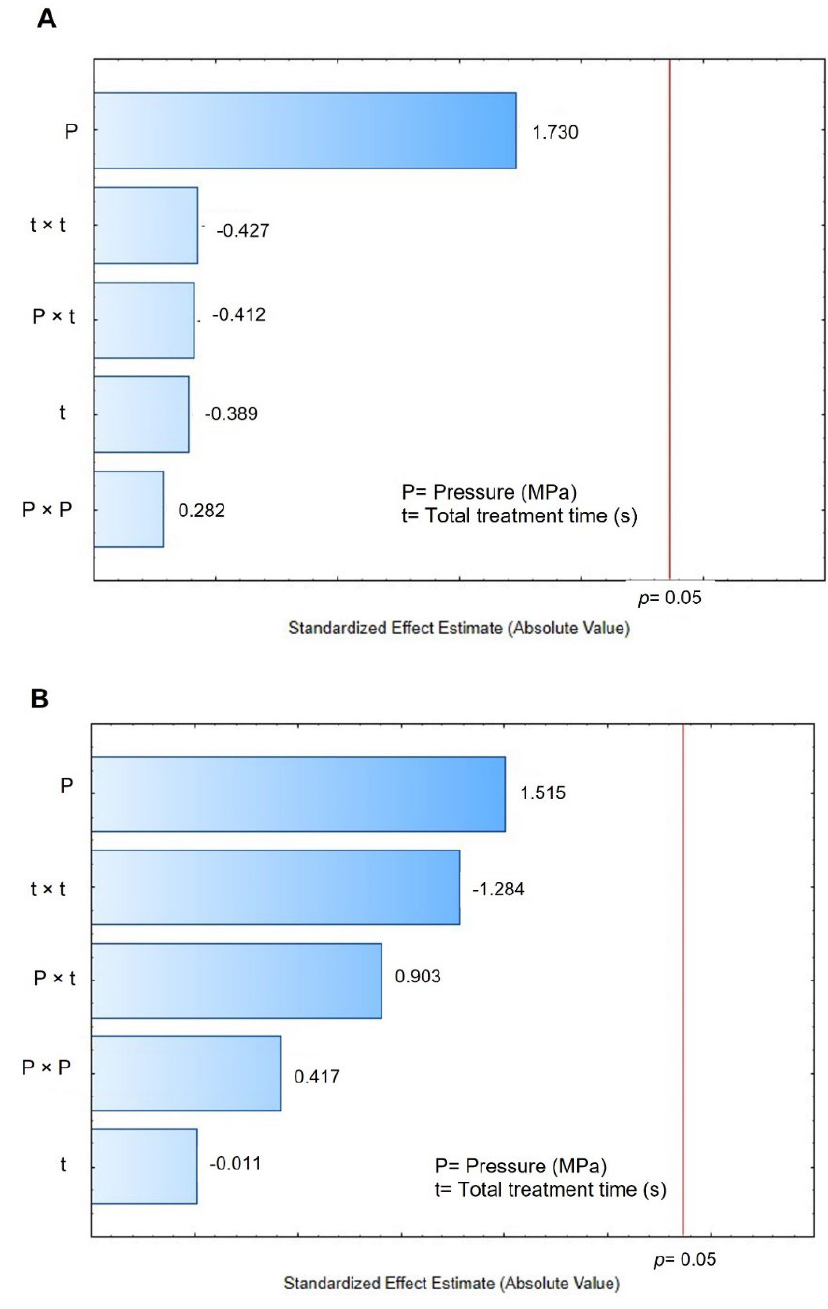
Figure 8. Effects of Pressure (MPa) and time (s) of DIC treatment on ( A ) starting accessibility of maize kernels during rehydration, and ( B ) water content of maize kernels after 2 h of rehydration.